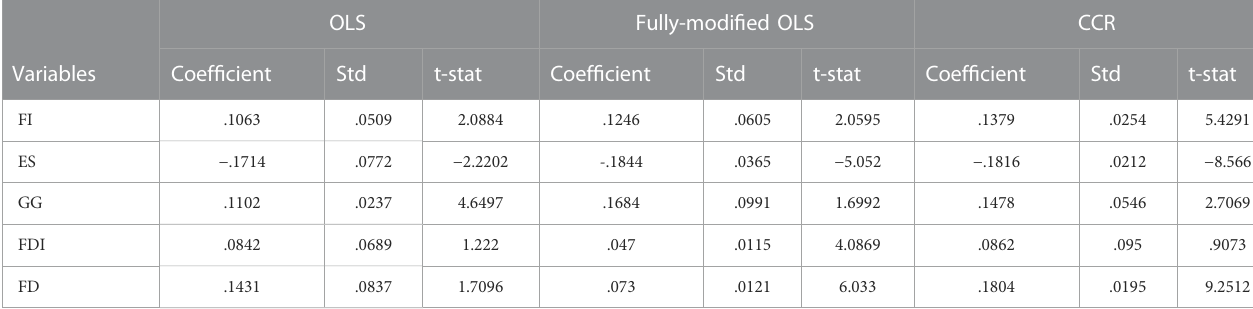
TABLE 12 Results of the coef fi cients robustness